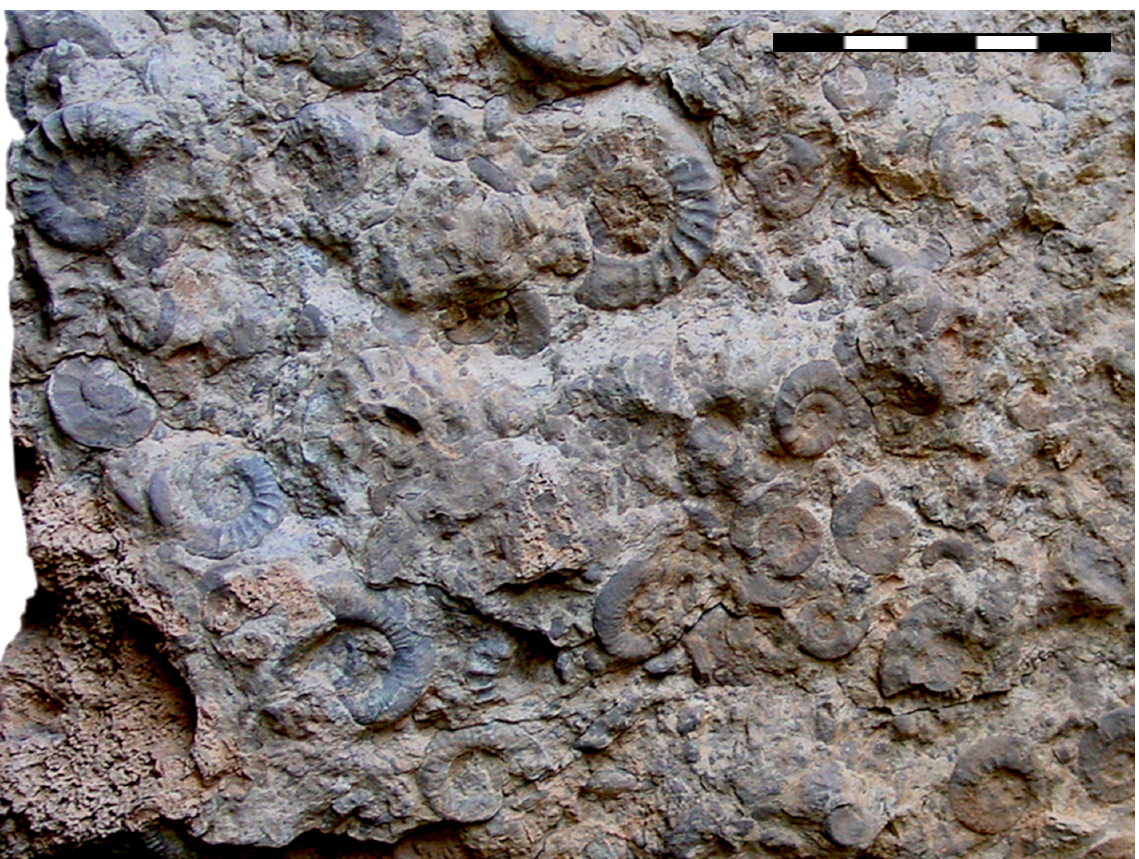
Fig. 12. Mass occurrence of small ammonoids of the genus Arasella Korn in Ghaderi et al. , 2014 on the bedding surface at the base of the topmost 5 cm limestone bed, Baghuk Mountain section H. Scale bar units = 10